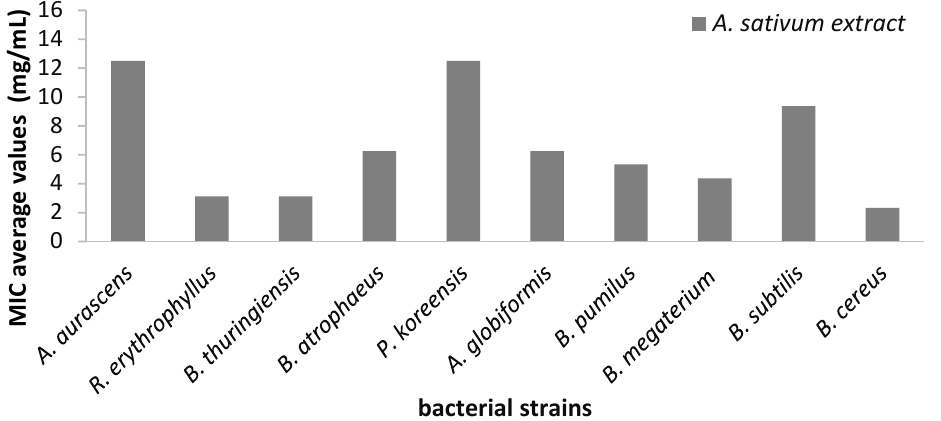
Figure 9. Average values of minimal inhibitory concentration (MIC) of A. sativum extract on different bacterial strains.